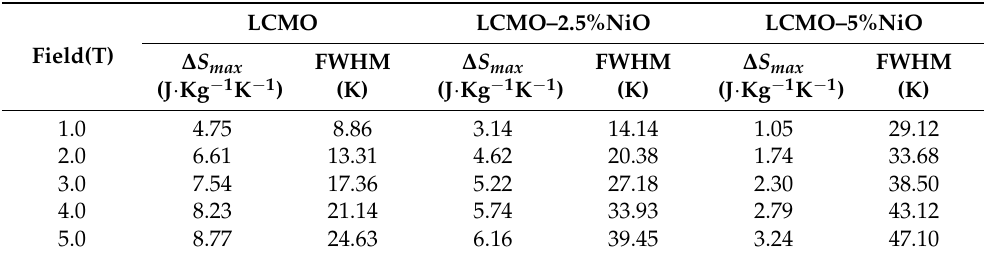
Table 4. Magnetic field dependence of maximum entropy change, and FWHM of LCMO–NiO composite samples.